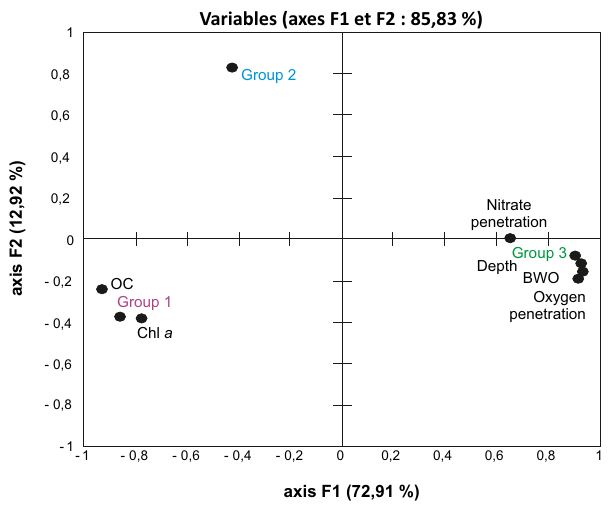
Fig. 7. CCA of the groups defined by PCA with the environmental parameters: bottom water oxygenation (BWO), chlorophyll a con- centration (Chl a ), amount of the organic carbon (OC), oxygen and nitrate penetration depth (cm) into the